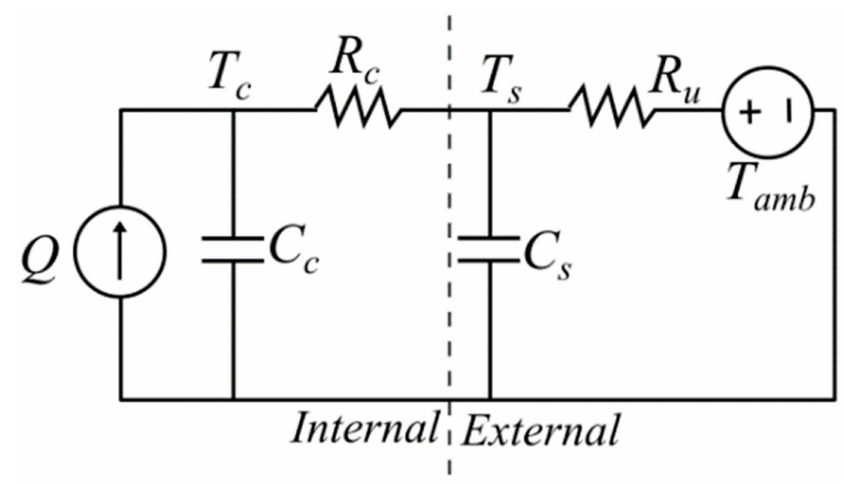
Figure 3. Second-order equivalent circuit thermal model of